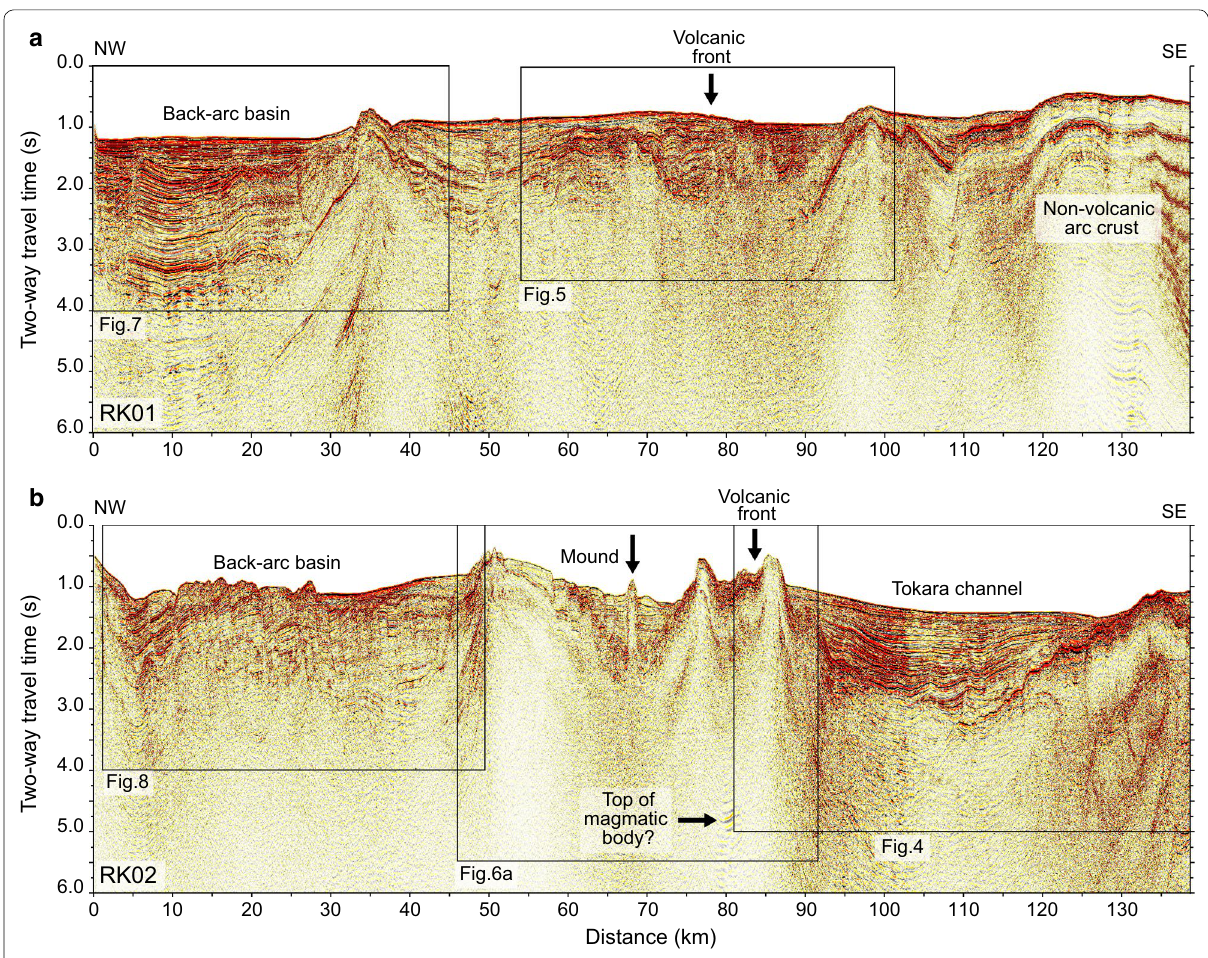
Fig. 3 Seismic reflection images across the northern Ryukyu arc. a RK01 profile. b RK02 profile. The locations of the profiles are shown in Fig. 1b (thick black lines). Black boxes indicate the locations of the close-up images in Figs. 4, 5, 6, 7 and